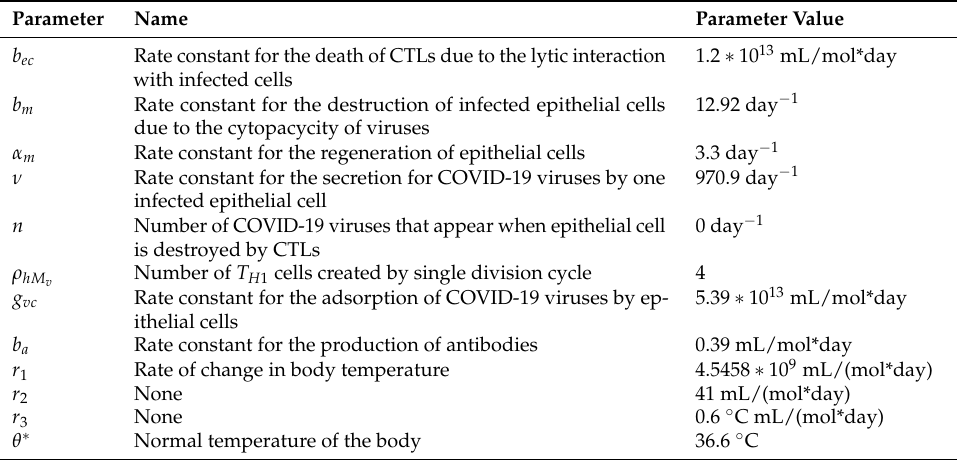
Table 4. Parameters used in the model